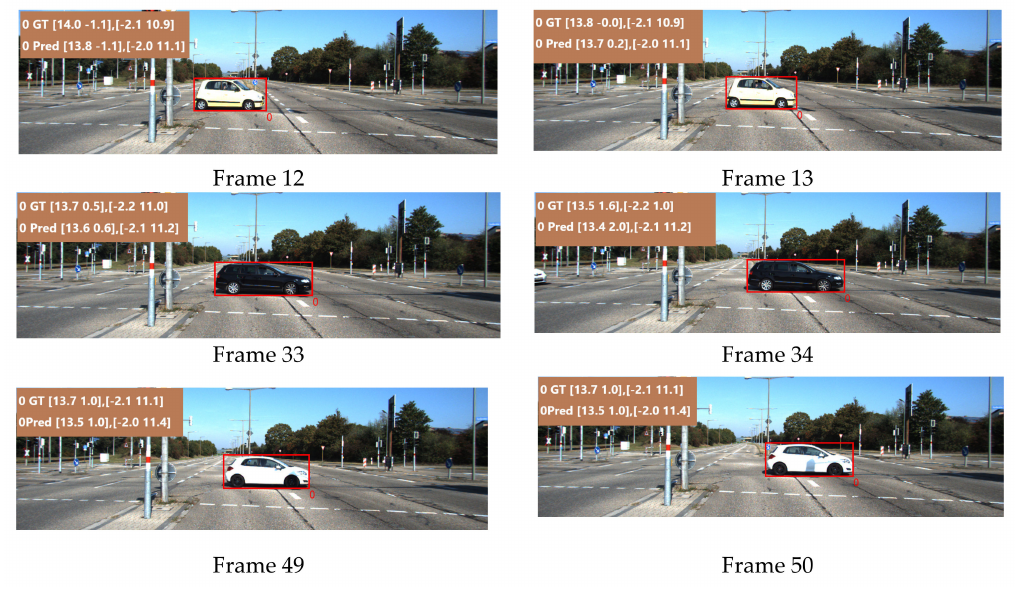
Figure 8. Prediction results of the target vehicle in the lateral incoming vehicle